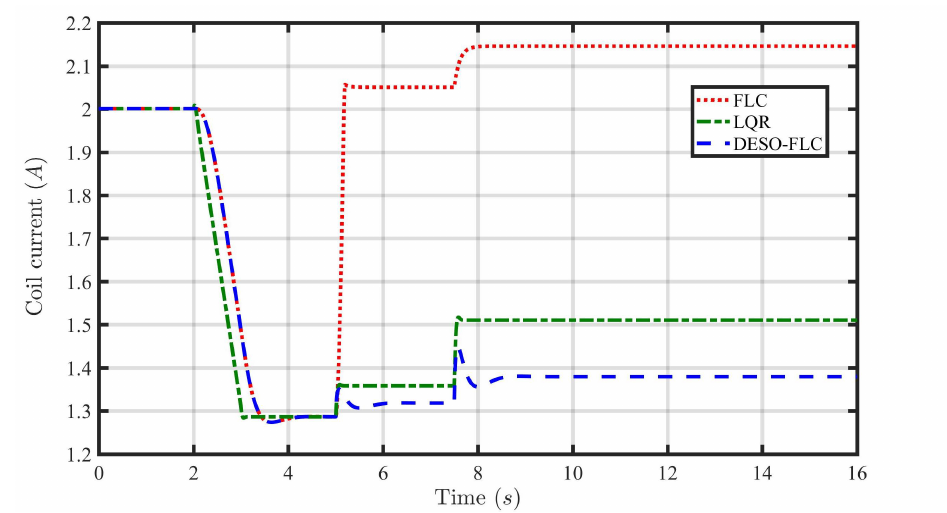
Figure 10. Response of coil current ( x 3 ) in the presence of parametric uncertainties.